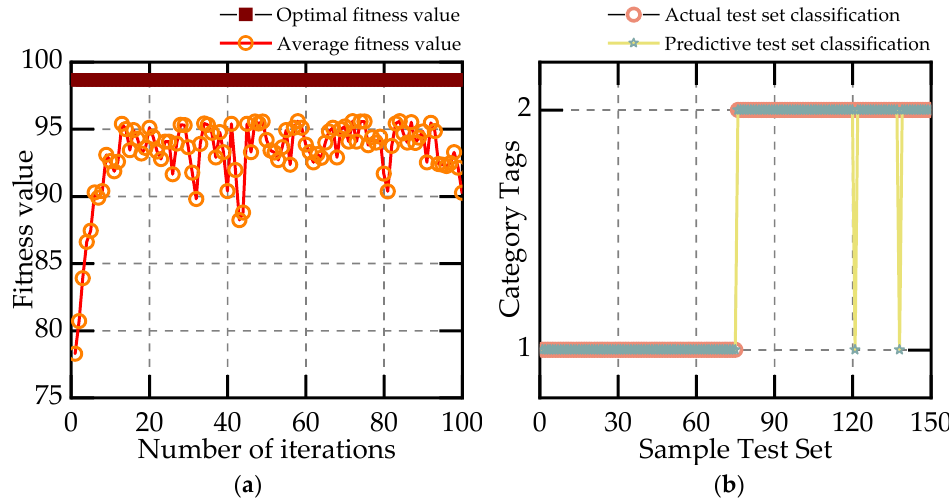
Figure 10. Classification graph of GA-SVM classifier. ( a ) Adaptability curve. ( b ) Classification chart.